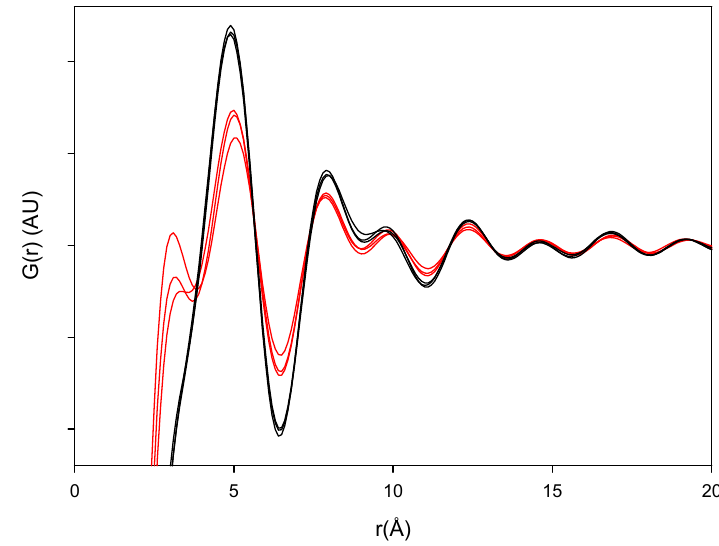
Figure 7. PDF patterns of the processed samples. Milled samples: black lines and quench cooled samples: red